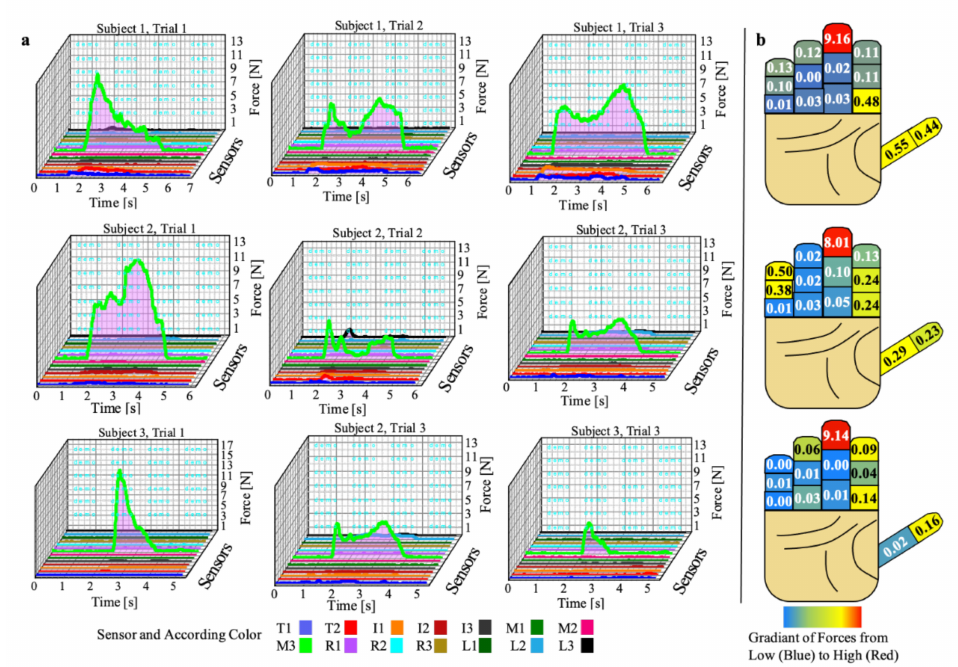
Figure 7. Can grasp results and analysis: ( a ) graphs of force during can grasp task with three subjects and three trials and ( b ) average maximum value during those three trials with a heat map of forces represented at each phalanx.